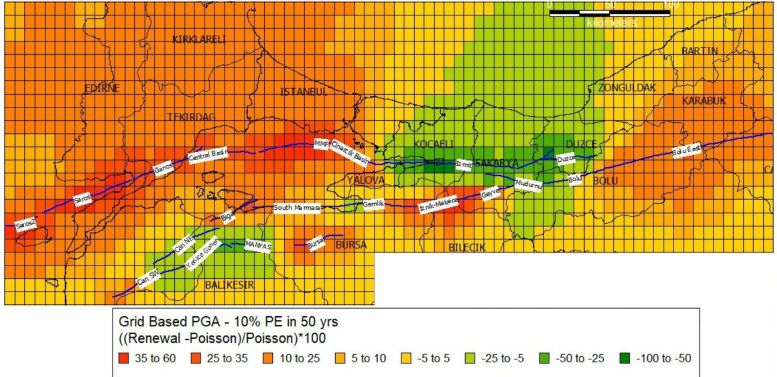
Figure 26. Di ff erence map corresponding to renewal vs Poisson approaches for 475-year PGA. It represents the ratio between the mean PGA seismic hazard by {[ PSHA Renewal − PSHA Poisson ] / PSHA Renewal } × 100, Poisson and Renewal (%10 in 50 yrs.), calculated using the background seismicity and individual fault segments. In red: positive amplifications. In green: negative